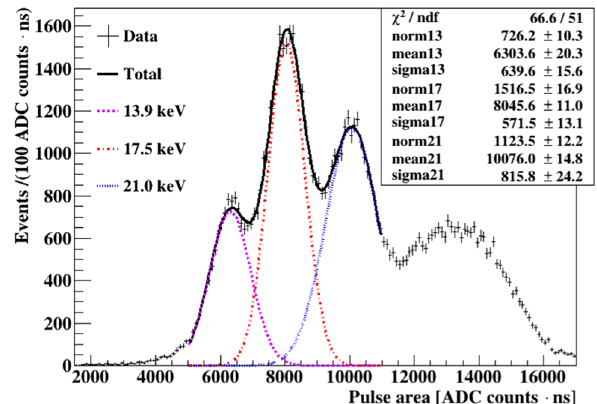
Fig. 6 Energy spectrum of 241 Am in the unit of ADC counts · ns Fig. 7 Simultaneous fitting of the 13.9, 17.5 and 21.0 keV X-ray peaks with three Gaussian functions